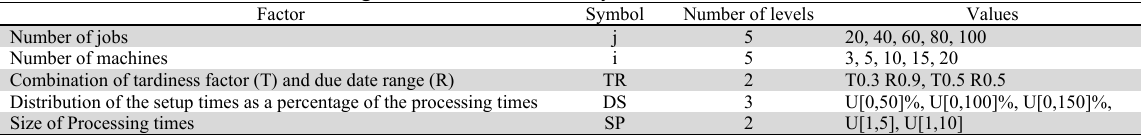
Factors for creation of medium and large size instances. Made by the authors